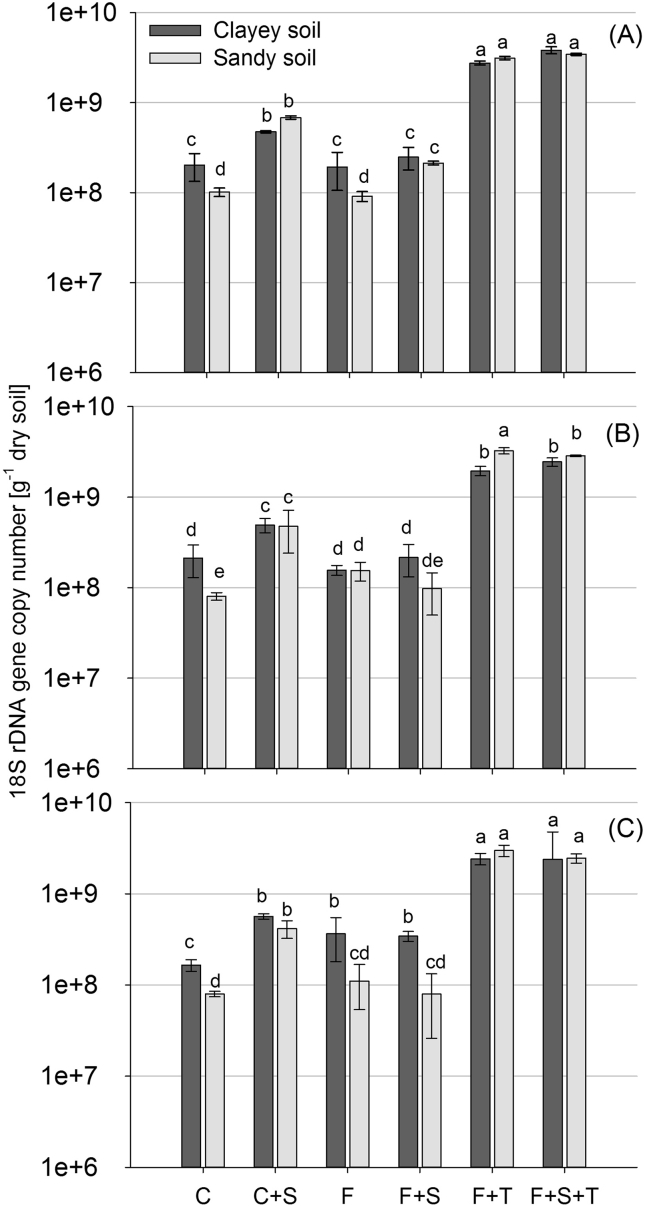
Adjusted total fungal abundance based on 18S rDNA gene copy numbers determined at 14 (A), 28 (B) and 42 (C) after ‘Foxy-2’ inoculation in the two soils (‘clayey’ (Humic Nitisol), ‘sandy’ (Ferric Alisol)). Different letters indicate significant differences at P < 0.05 and error bars represent standard error. Treatment codes are: uncoated maize (C), uncoated maize with S. hermonthica (C + S), coated maize with ‘Foxy-2’ (F), coated maize with ‘Foxy-2’ and S. hermonthica (F + S), coated maize with ‘Foxy-2’ and T. diversifolia (F + T), and coated maize with ‘Foxy-2’, S. hermonthica and T. diversifolia (F + S + T).